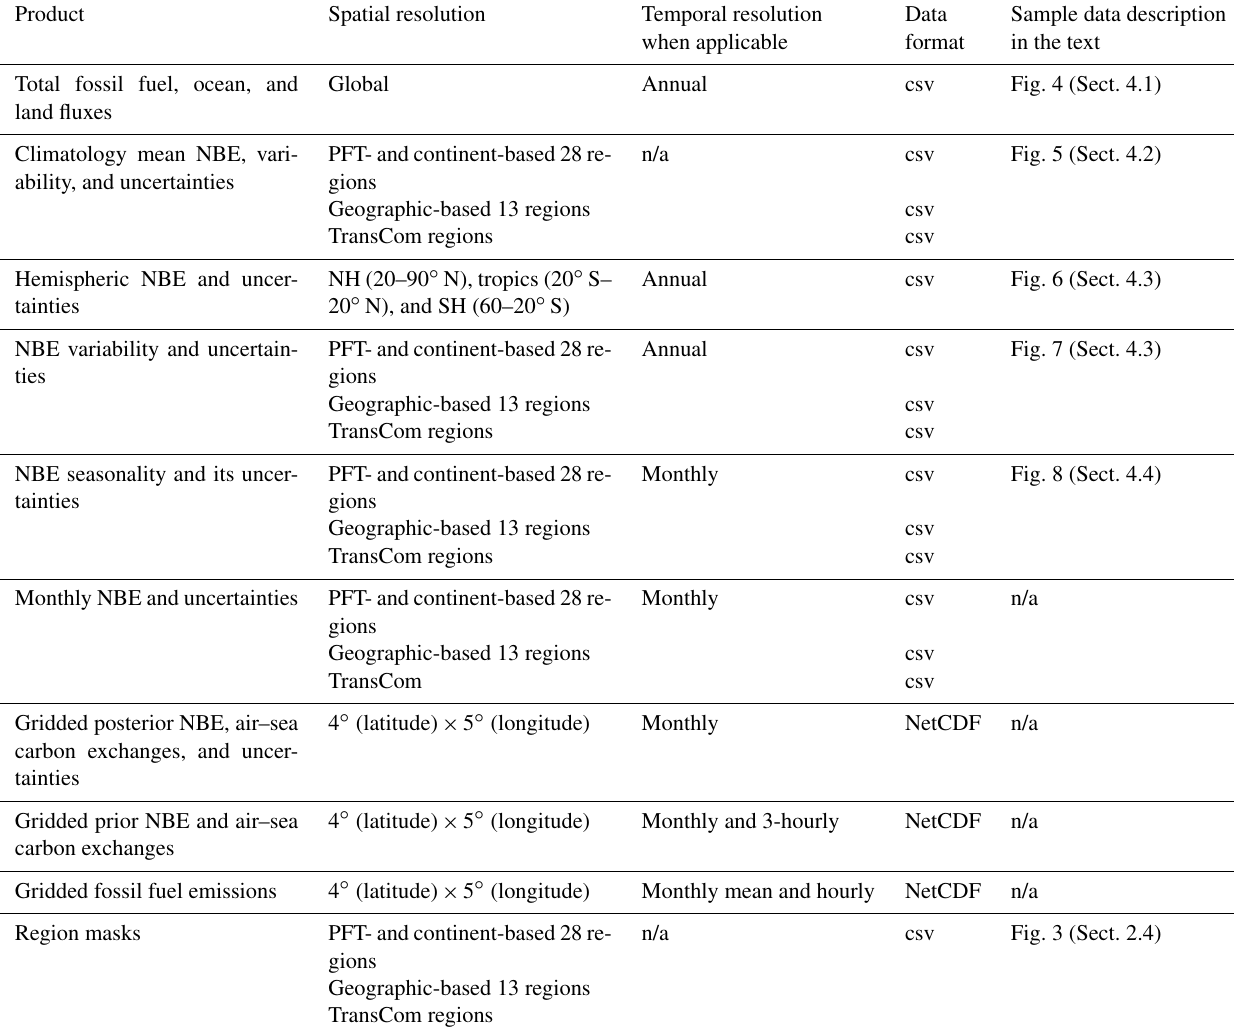
Table 5. List of the data